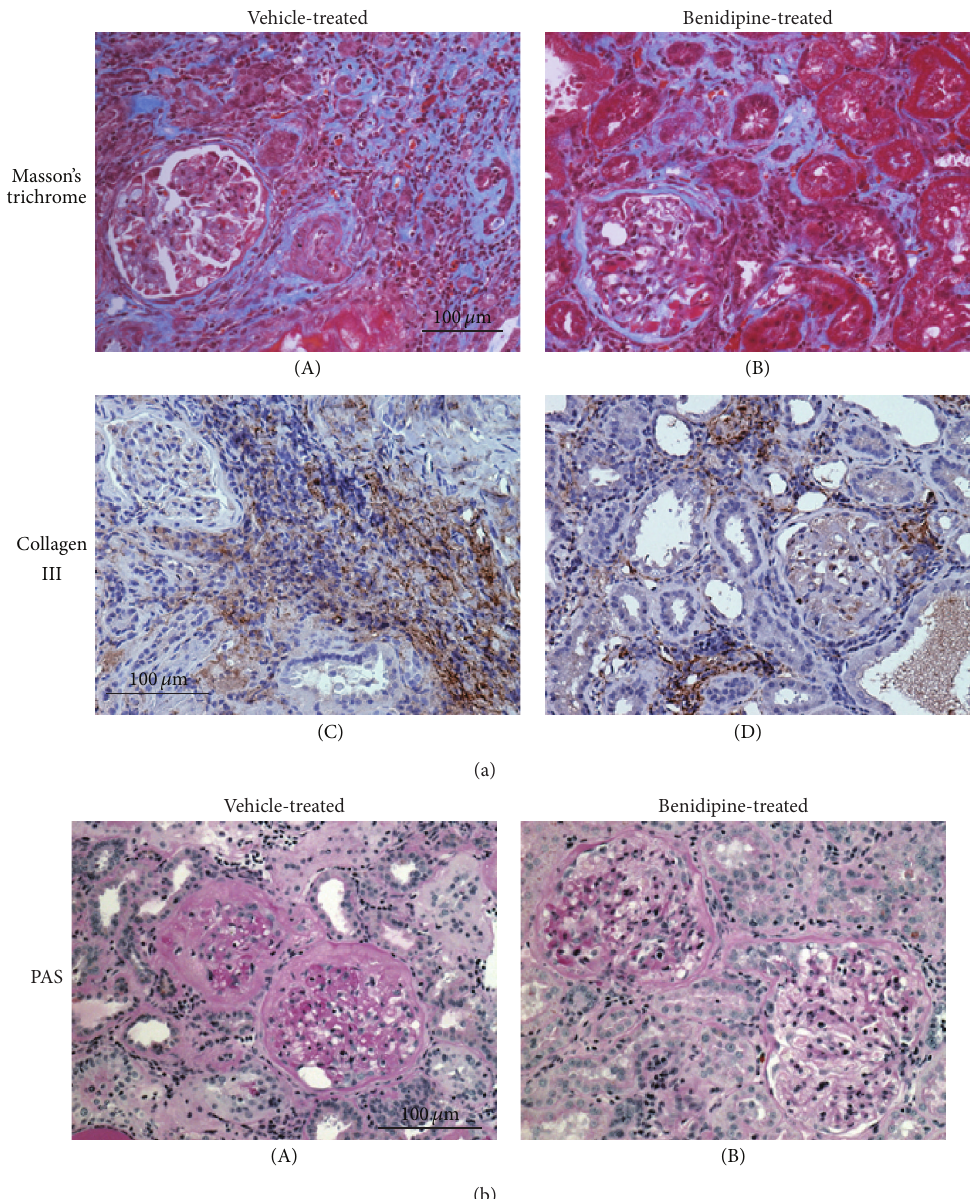
Figure 5: Fibrotic marker expression and histological features of glomeruli in vehicle- and benidipine-treated CRF rat kidneys. (a) Masson’s trichrome staining ((A) and (B)) and immunohistochemistry using antibody for collagen III ((C) and (D) brown) in vehicle-treated and benidipine-treated CRF rat kidneys. Low-power views of the cortex. Magnification, × 20. (b) Periodic acid Schiff (PAS) staining in vehicle- treated and benidipine-treated CRF rat kidneys. Low-power views of the cortex. Magnification, × 20. Modified from